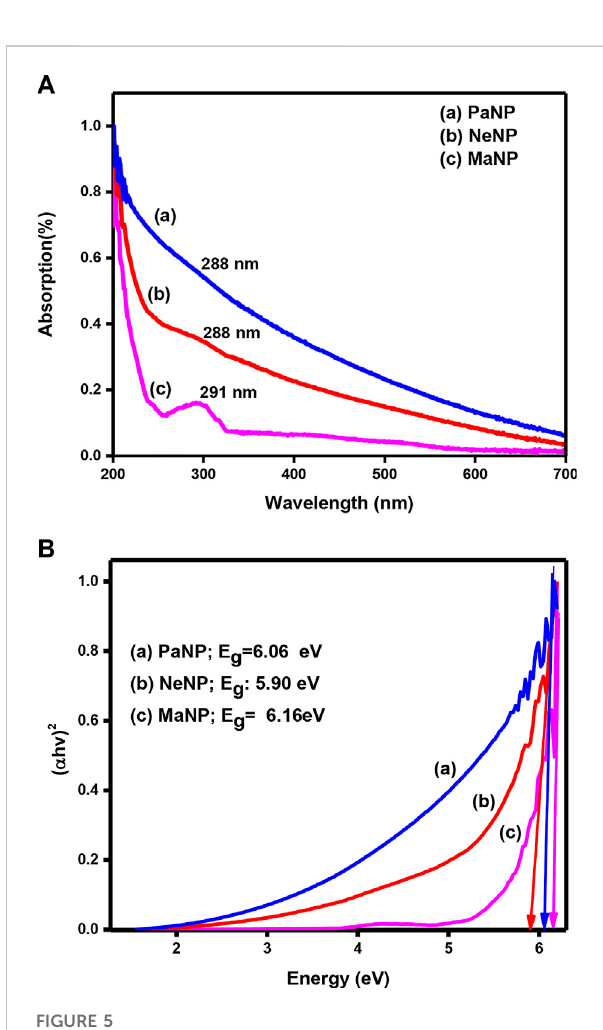
FIGURE 5 (A) UV-Visible absorption spectra and (B) Tauc plot of MgO nanoparticles prepared using Pa, Ne , and Ma plant